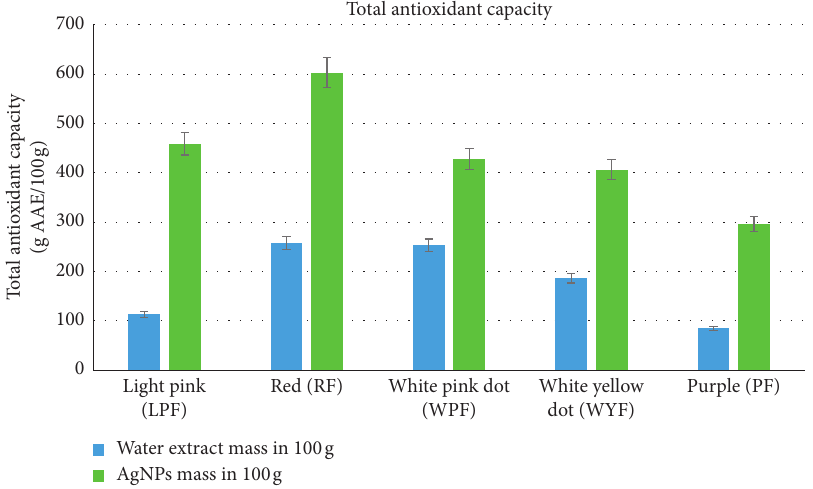
Figure 13: Total antioxidant capacity of water extracts and AgNPs expressed as ascorbic acid equivalents (AAE).